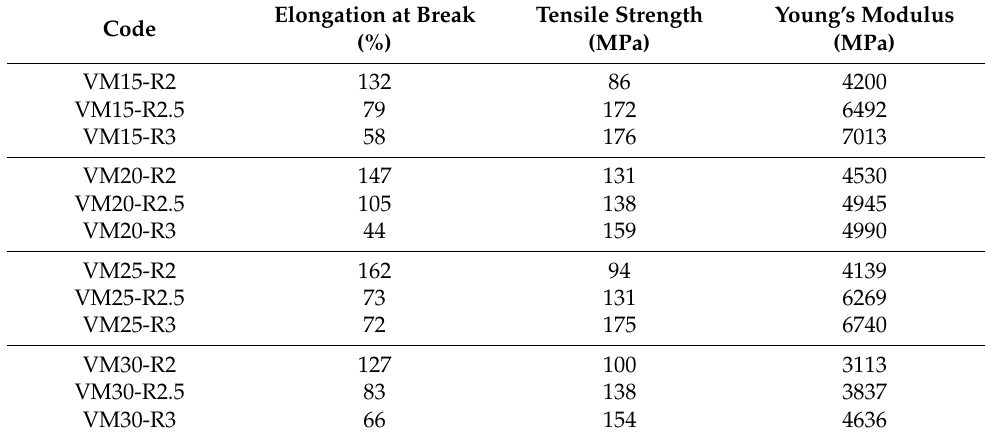
Table 3. Mechanical properties of PVDF/PMMA blends with varied